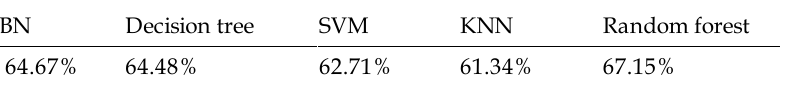
Table 11. Comparison of corrected prediction rates of BNs and the other four classification methods using a 5-fold cross validation method